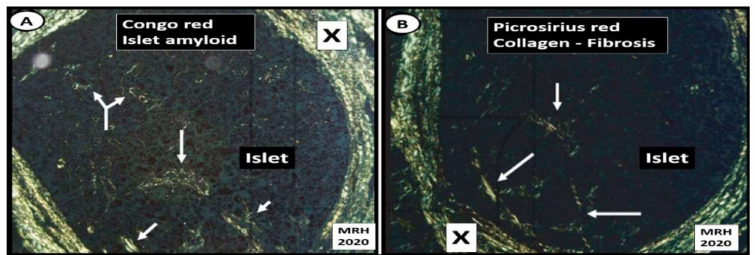
Figure 12. Islet amyloid and islet fibrosis in human islets co-occur. (Panel ( A )) depicts Congo red staining (stains amyloid) viewed with crossed polarized light and birefringent appearance at the peri-islet (X) and intra-islet regions (arrows). (Panel ( B )) illustrates islet fibrosis (collagen I and III) staining with picrosirius red and viewed with crossed polarized light of pancreatic islet at the peri-islet (X) and intra-islet regions (arrows). These images demonstrate that islet amyloid and islet fibrosis co-occur within human pancreatic islets when stained specifically for amyloid (Congo red) and fibrosis (picrosirius red) in a female patient who died of an acute myocardial infarction [54]. Specific staining procedures by pathologists often reveal what standard hematoxylin and eosin (H&E) staining do not in regard to conditions such as islet amyloid and fibrosis. Magnification × 100 objective with oil immersion in Panels ( A , B ).